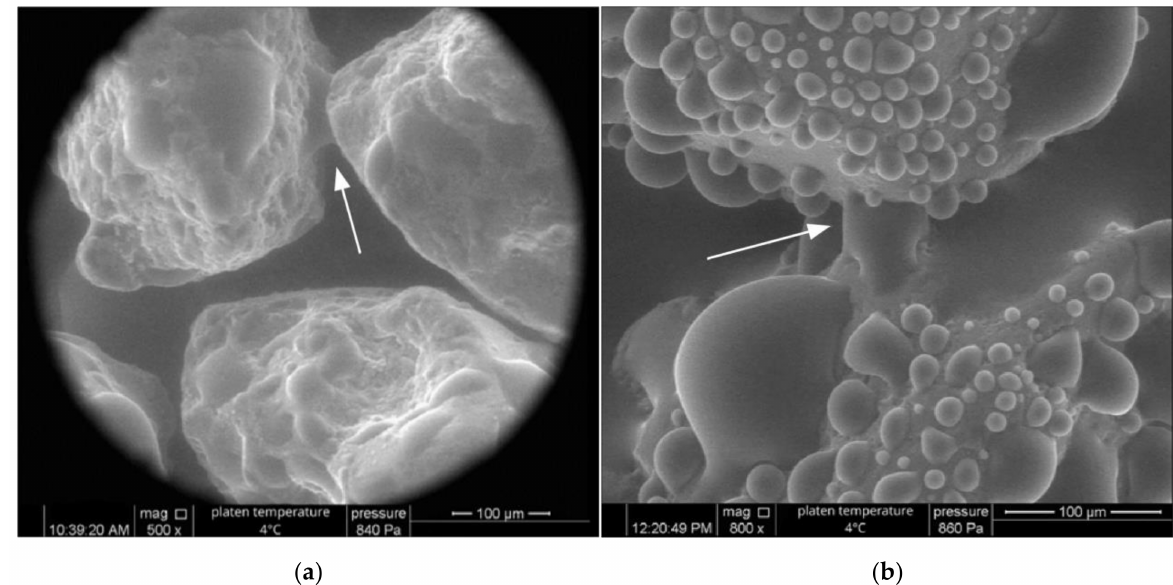
Figure 7. ESEM images obtained during wetting of the natural sand ( a ) and hydrophobized sand ( b ). The arrows indicate the menisci bridging between